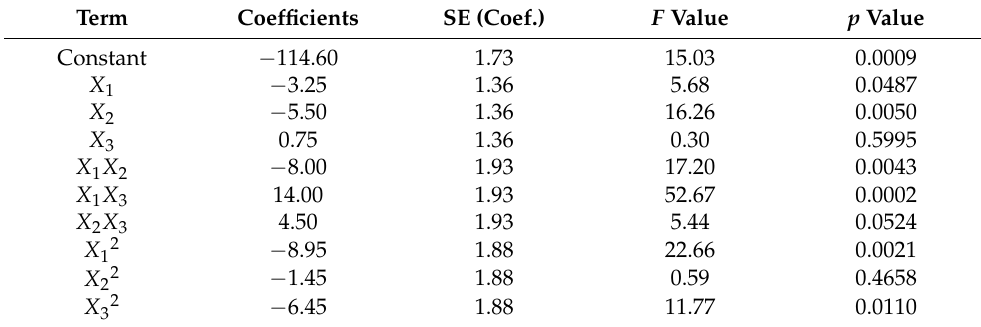
Table 5. Statistical analysis results of BBD data for deformation.